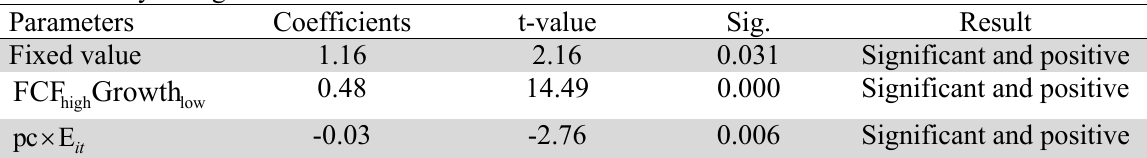
The summary of regression model